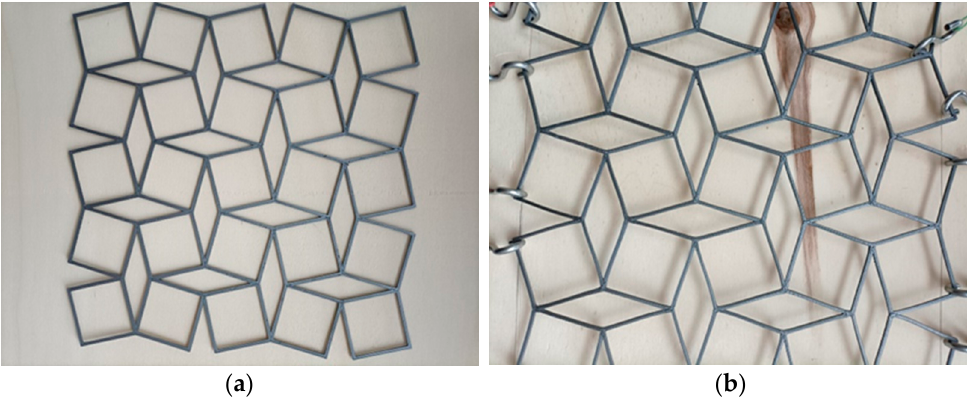
Figure 10. “Mesh” structure made of hard polymer, in initial position ( a ) and after stretching in two perpendicular directions ( b ).